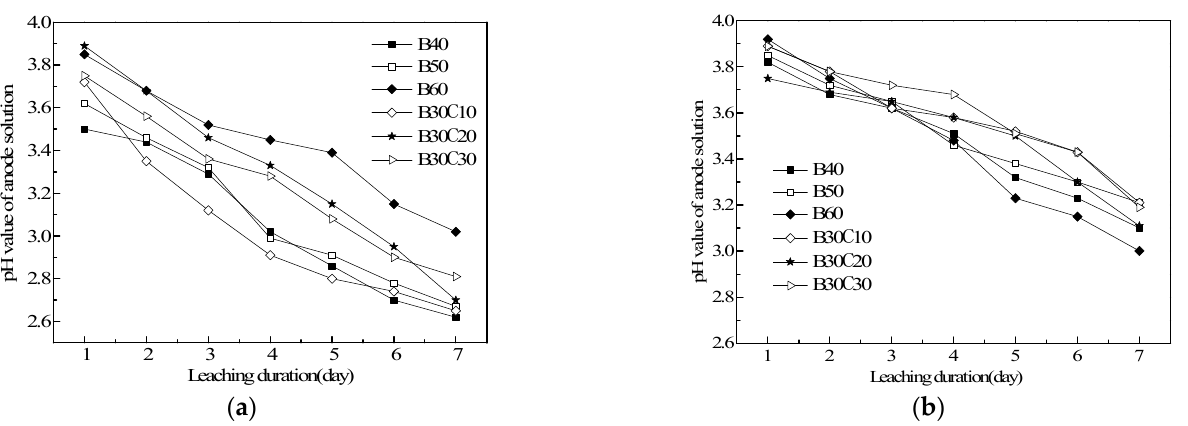
Figure 4. Relationship between pH value of anode solution and leaching duration. ( a ) first week ( b ) second week.